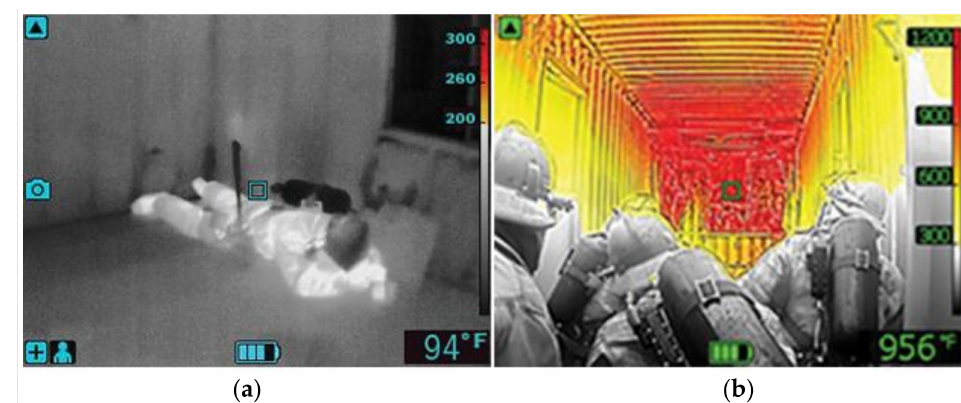
Figure 3. Different sensitivity image comparison ( a ) Medium sensitivity: 0 ◦ F–300+ ◦ F ( b ) Low Sensitivity: 0 ◦ F–1200 ◦ F (Source: TechValidate. TVID: B52-065-90D)